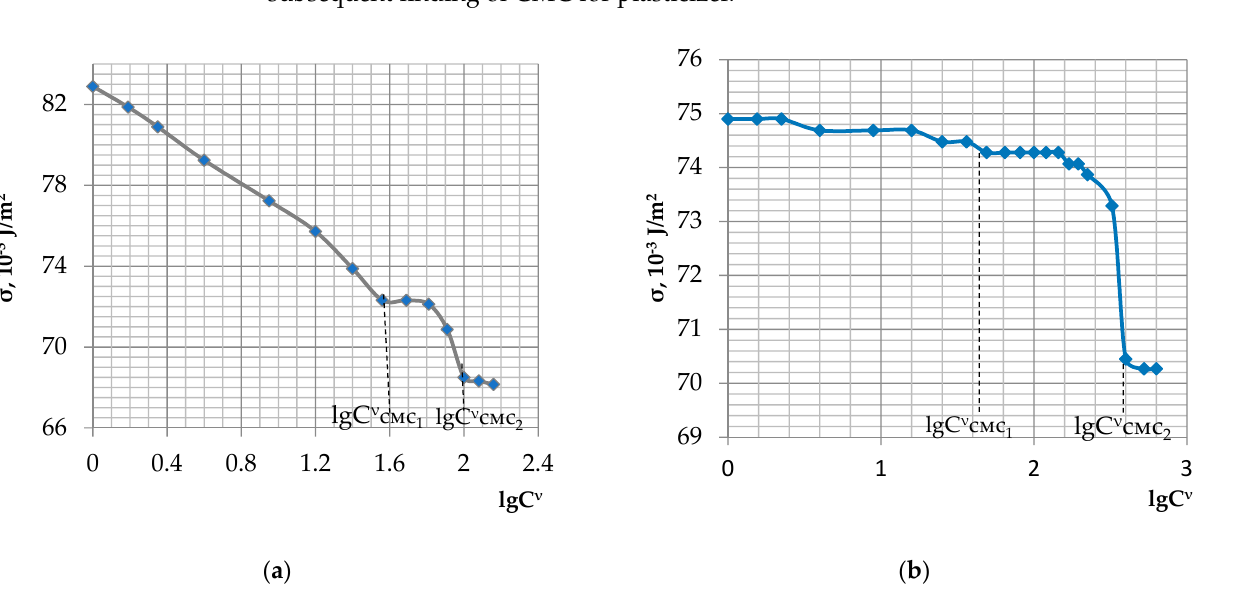
Figure 17. Gibbs adsorption isotherm of the plasticizer in Г -C ν coordinates: ( a )—in soft water No. 1, ( b )—in hard water No. 2.